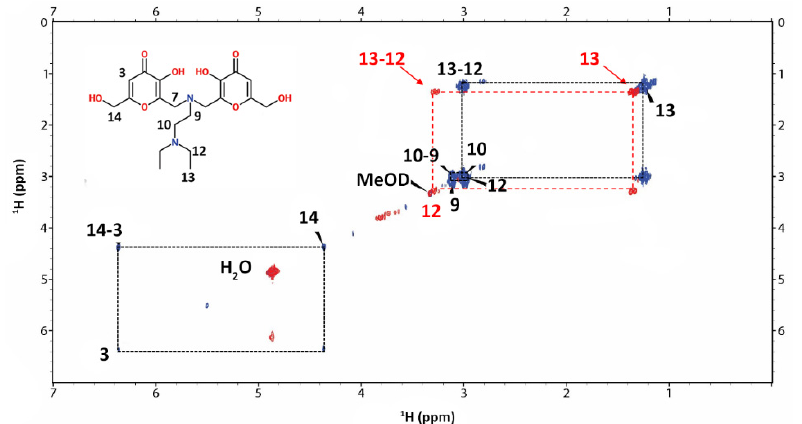
Figure 8. 1D 1 H NMR spectra of L9-V IV O 2+ system in MeOD at different L9:V IV O 2+ ratios.